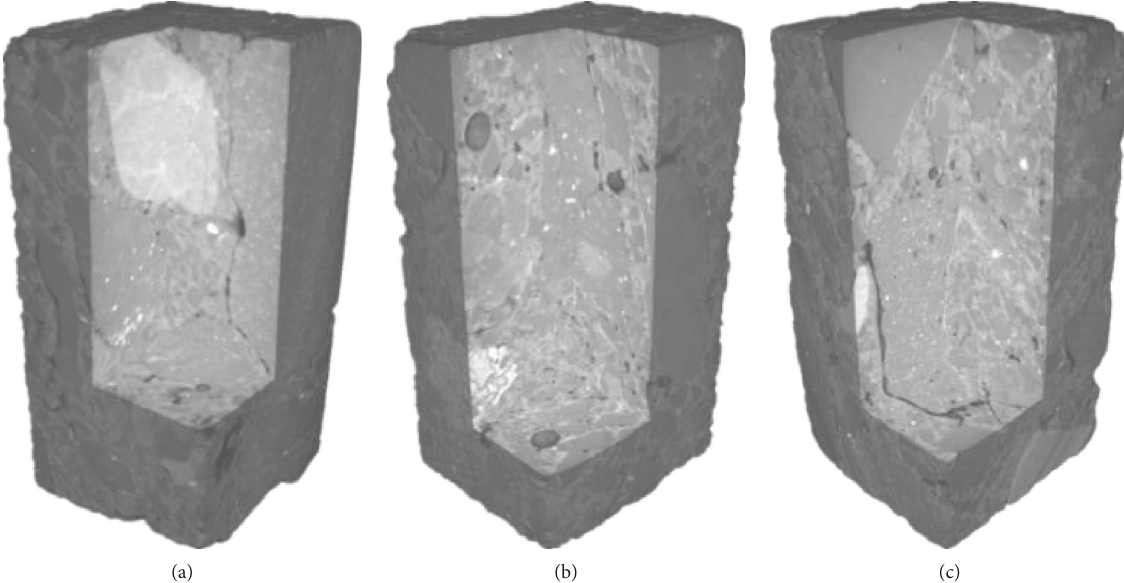
Figure 4: Processed 3D image of specimens: (a) fiber volume fraction is 0.10%; (b) fiber volume fraction is 0.20%; and (c) fiber volume fraction is 0.30%.